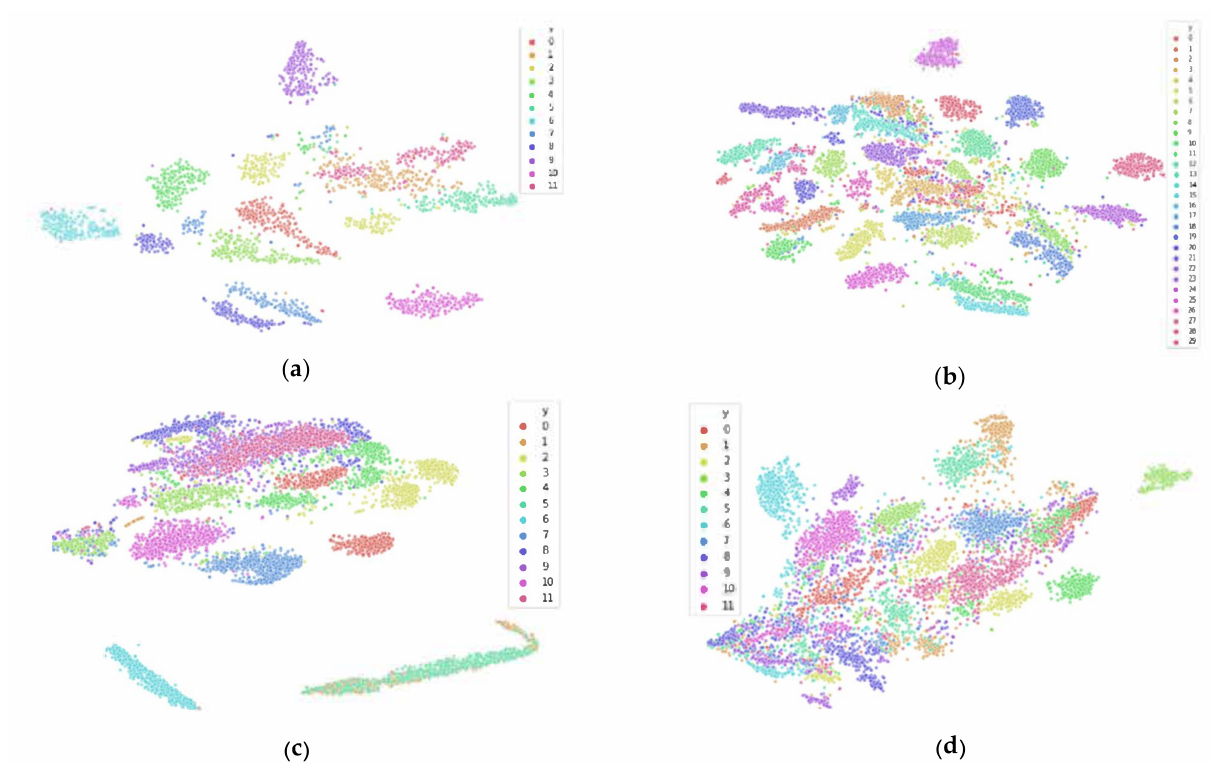
Figure 6. Example of using t-SNE for 2D dimensionality reduction and visualization of datasets utilized within this research, with colors corresponding to participants within the datasets, showcasing that inter-participant variability is present across different tasks and participant populations. Datasets depicted here are spectral features of the ( a ) PTSD, ( b ) Schizophrenia, ( c ) and Driver Fatigue datasets; and ( d ) Entropy features of the Driver Fatigue dataset. The dimensions of t-SNE are arbitrary distances that represent that closer neighboring points in low-dimensional space are likely to be neighbors in high-dimensional